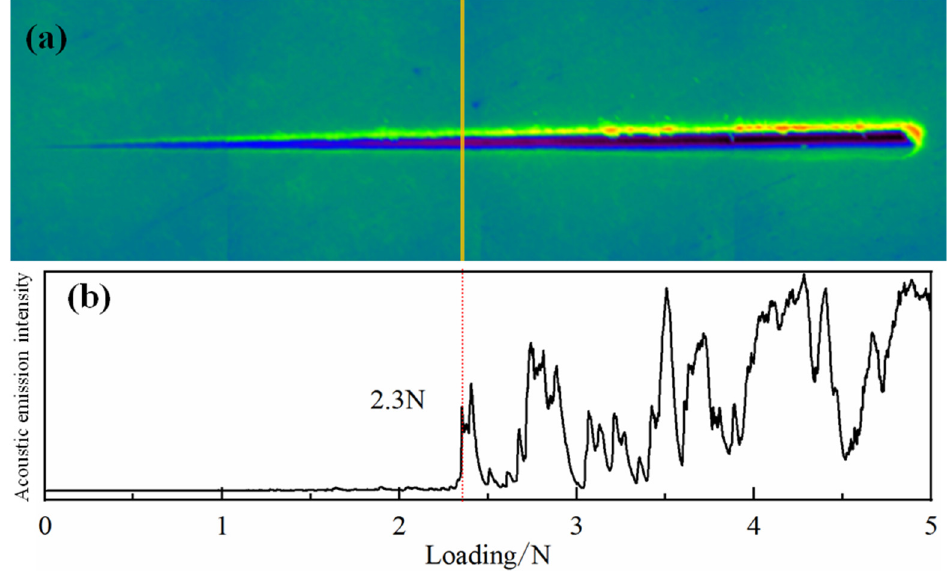
Figure 4. Detailed analysis of h-BN coatings. ( a ) microscopic record, ( b ) the acoustic emission record showing the critical load of the coatings first penetration.